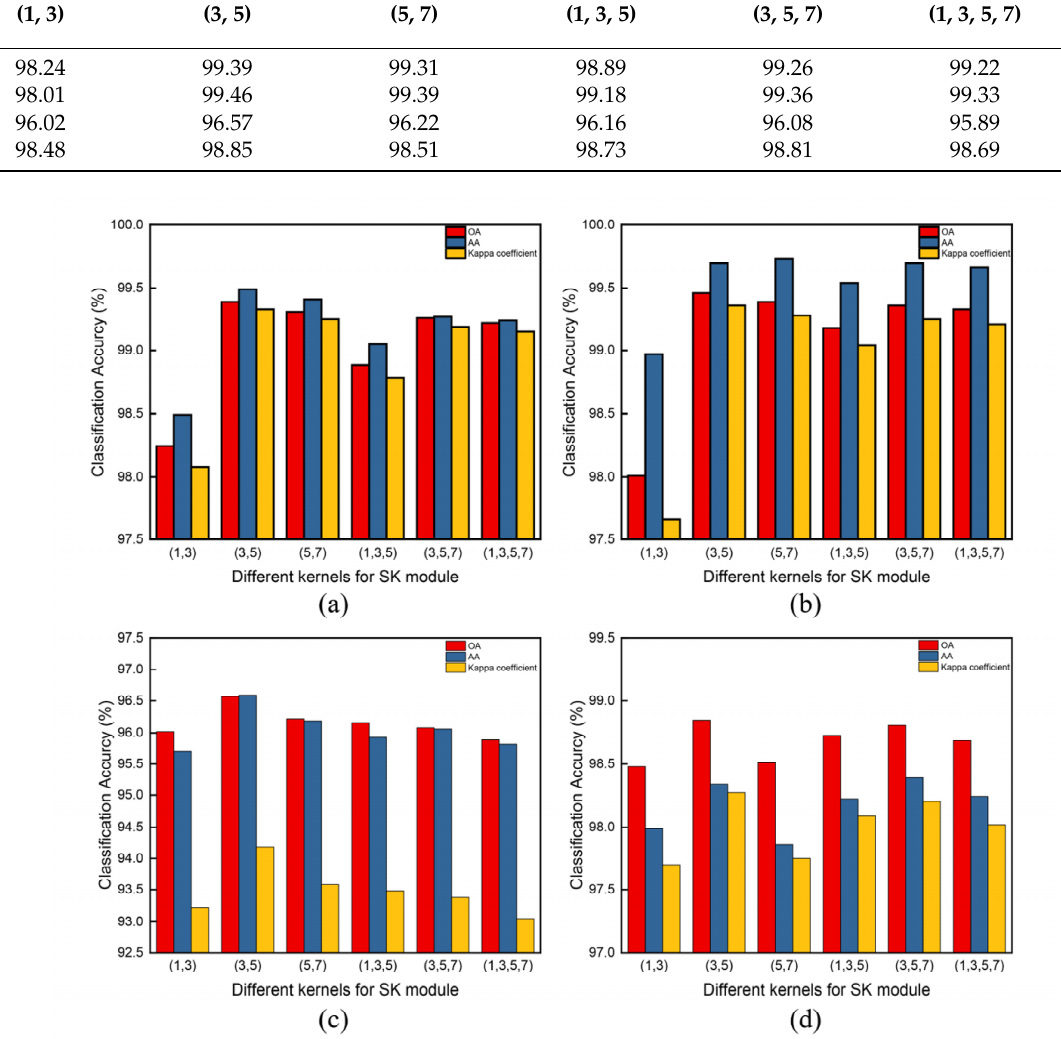
Figure 13. Classification accuracy changes with different kernel groups: ( a ) Flevoland-15 dataset; ( b ) Flevoland-14 dataset; ( c ) Oberpfaffenhofen dataset; ( d ) San Francisco